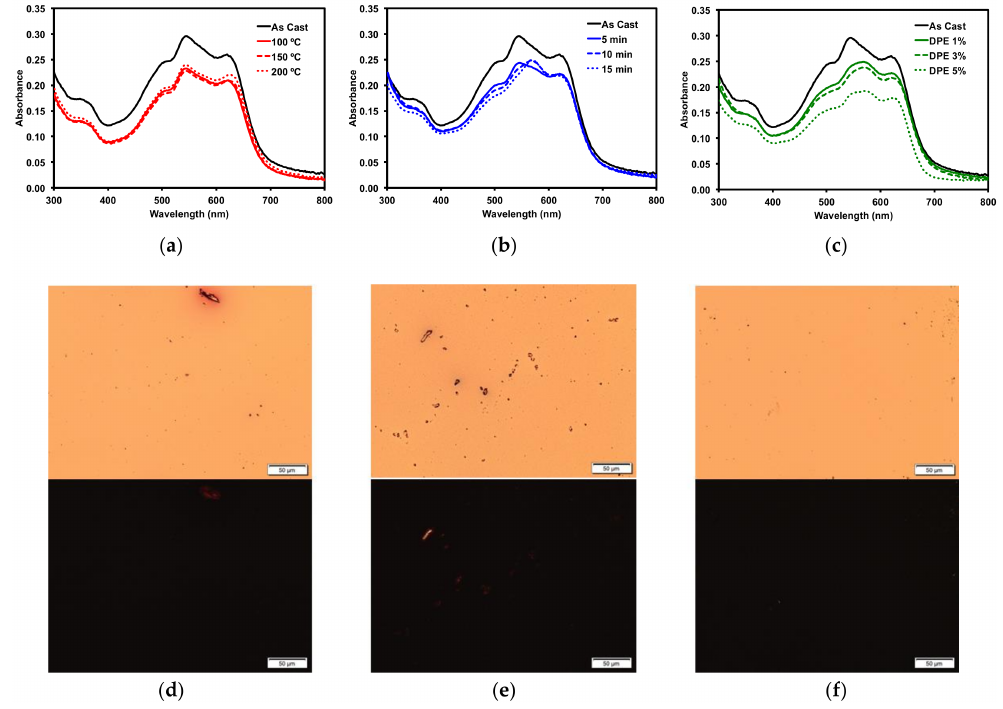
Figure 6. Absorption profiles of 50:50 PBDB-T /1 blend with ( a ) TA; ( b ) o -DCB SVA; ( c ) DPE solvent additive. POM images of ( d ) 150 ◦ C TA film; ( e ) 15 min o -DCB SVA film; and ( f ) 3% v/v DPE additive film under normal (top) and cross-polarized light (bottom). Images were taken at 20 ×